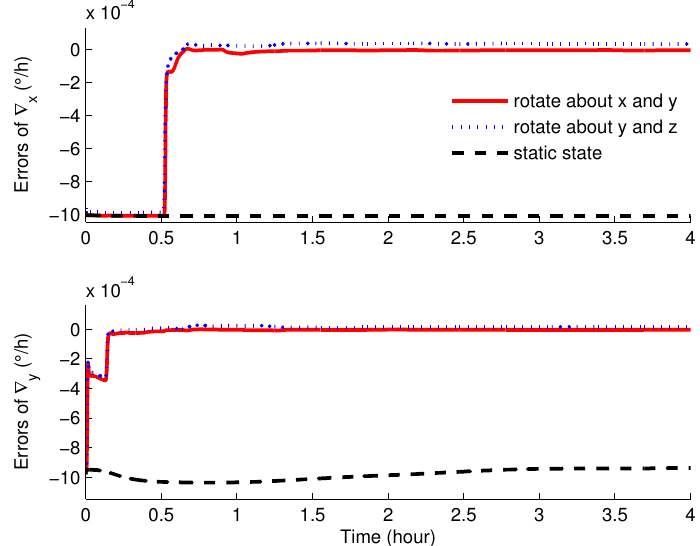
Figure 9. The estimated errors of the horizontal accelerometer biases of the rotation and static simulations.